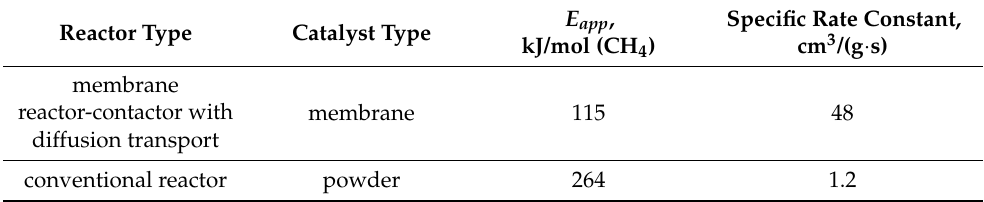
Table 2. Comparison of parameters of DRM in conventional and membrane